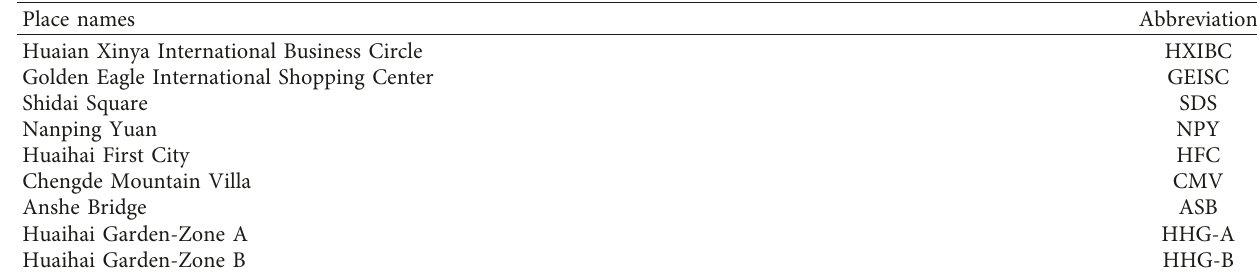
Figure 3: The location of HXIBC and its surrounding residential areas. Table 4: List of place name